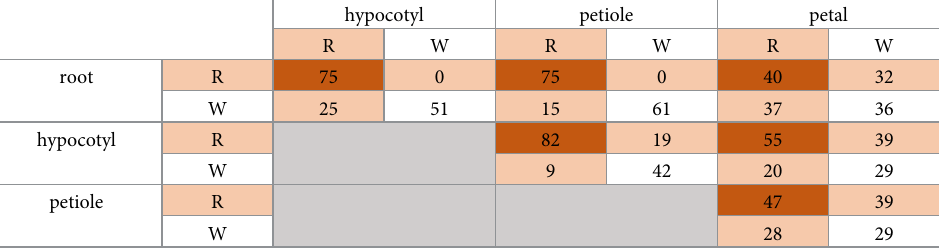
R7 to root skin color, we have carefully chosen candidate genes according to the following cri- teria: first, differential expression levels between red and white root radishes (S3 Fig); second, root-specific expression reported in the Radish Genome Database (radish-genome.org); and third, regulatory functions for anthocyanin biosynthesis reported in other plant species. Eight genes were selected and subjected to further analysis to verify their contribution to root skin color as a putative R locus gene (Table 2). Their expression levels were determined by qRT-PCR (Fig 4a), and three of them were shown to have significant differential expressions between red and white root tissues. A putative RNA-binding protein (R7_9141477–9142640) was highly expressed in white roots compared to red roots, whereas both MYB114-like tran- scription factor (Rs388430, called RsMyb1 hereafter) and isoflavone reductase (Rs386960, called RsIFR1 hereafter) were expressed at higher levels in red root tissues than in white ones (Fig 4a). Phylogeny analysis revealed that RsMyb1 was clustered together with the R2R3 motif transcription factors such as MYB113, MYB114, PAP1 and PAP2, all of which are known to be involved in the regulation of anthocyanin biosynthesis in other plant species (S4 Fig) [7]. Fur- ther expression analysis on red and white root radish cultivars also revealed that RsMyb1 was expressed at significantly higher levels in red root cultivars than in white root cultivars (Fig 4b). This strongly suggests that RsMyb1 expression is specific to red radish roots and deter- mines the external root color of radish by regulating anthocyanin biosynthesis. RsMyb1 was cloned from red and white root F individuals and their sequences were compared each other. 3 RsMyb1 genes isolated from red and white root radishes (called RsMyb1-R and RsMyb1-W , respectively) are predicted to encode the polypeptides with the same size (249 amino acids) but with differences in amino acid composition at 18 positions (S5 Fig). However, these amino acid differences are unlikely to cause differential activities between RsMyb1-R and RsMyb1-W considering the conserved structure of RsMyb1 compared to other MYB transcription factors. Moreover, RsMyb1-R is more similar to RsMyb1 isolated from white root WK10039 cultivar, and RsMyb1-W is similar to RsMyb1 of red root Bordeaux (S5 Fig). Comparison of the nucleotide sequences outside the RsMyb1 coding region also revealed 13 indels and 14 SNPs between RsMyb1-R and RsMyb1-W alleles (data not shown), suggesting that these differences in cis -element might be responsible for differential expression of RsMyb1 in red and white root